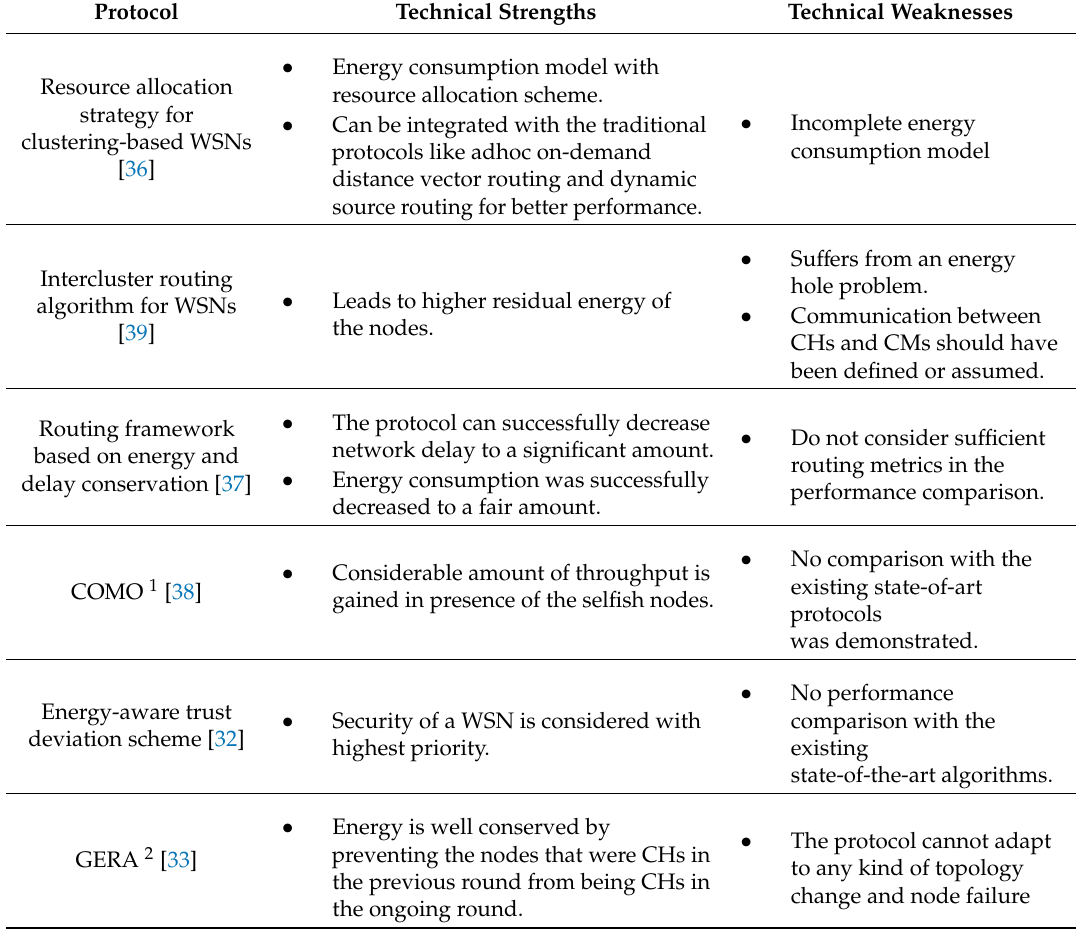
Table 5. Comparison of routing protocols based on noncooperative games in terms of technical strengths and